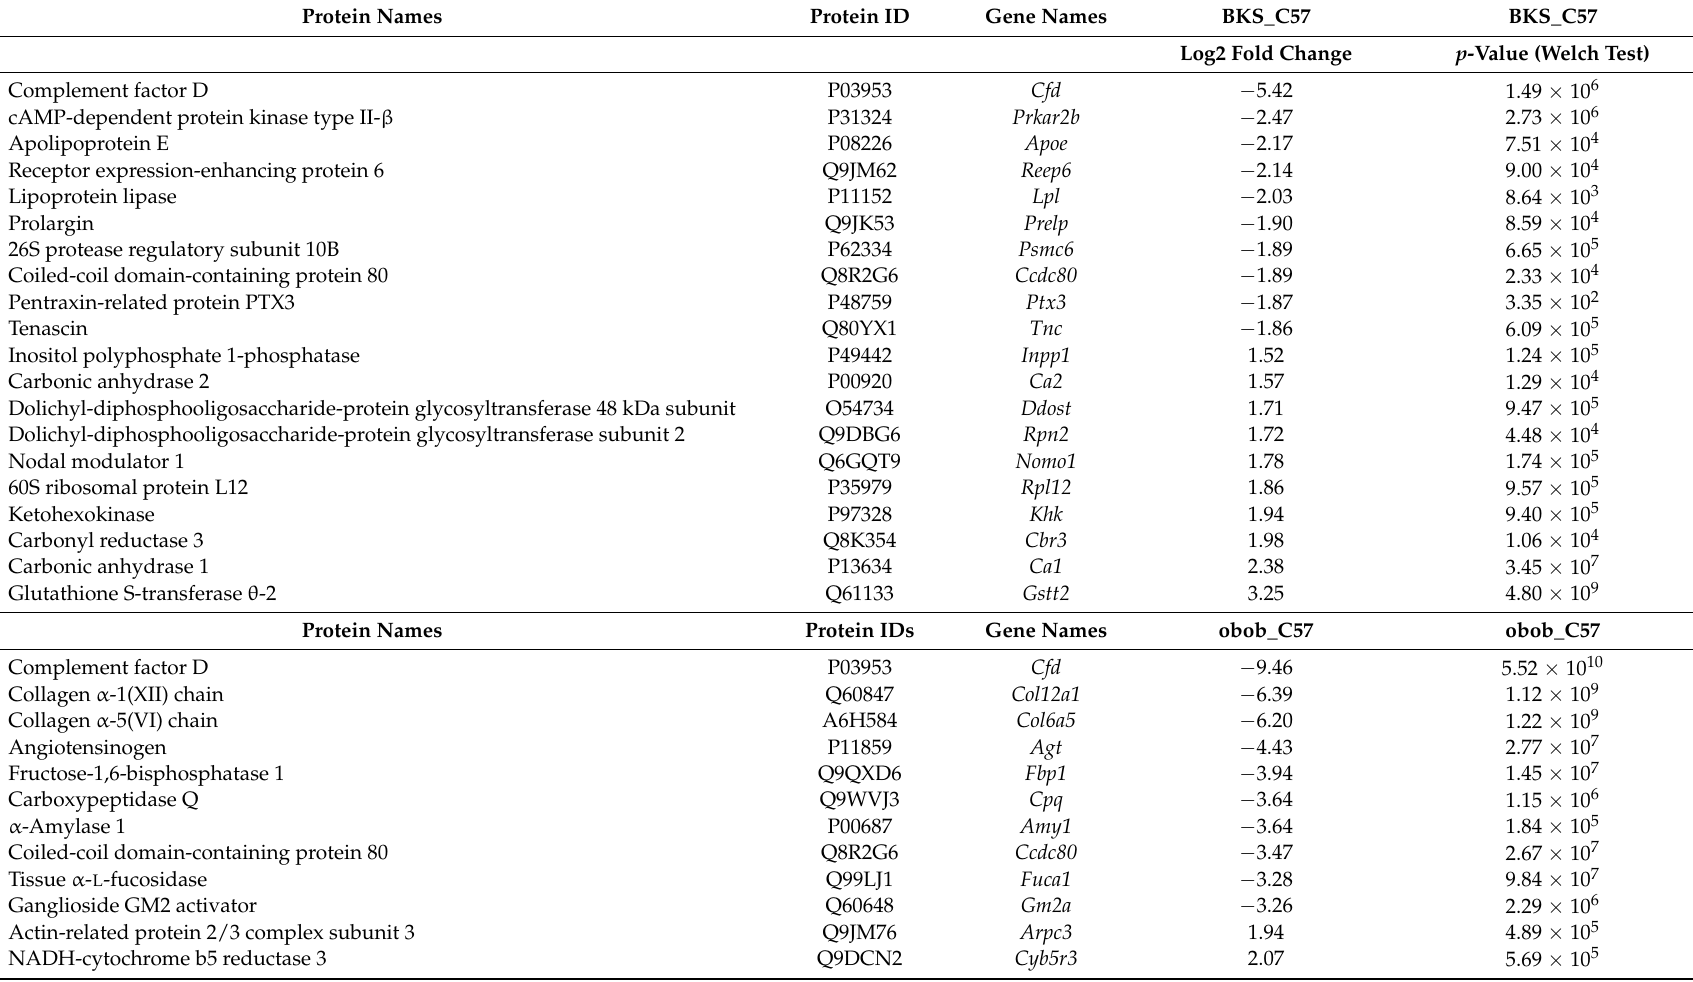
Table 1. Top putatively regulated proteins (SP(+), SP( − )) in the